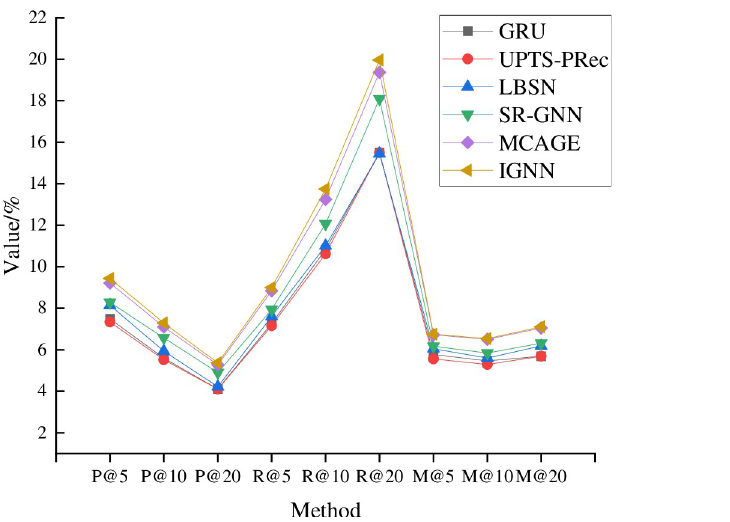
Fig 8. Model training results on the Foursquare